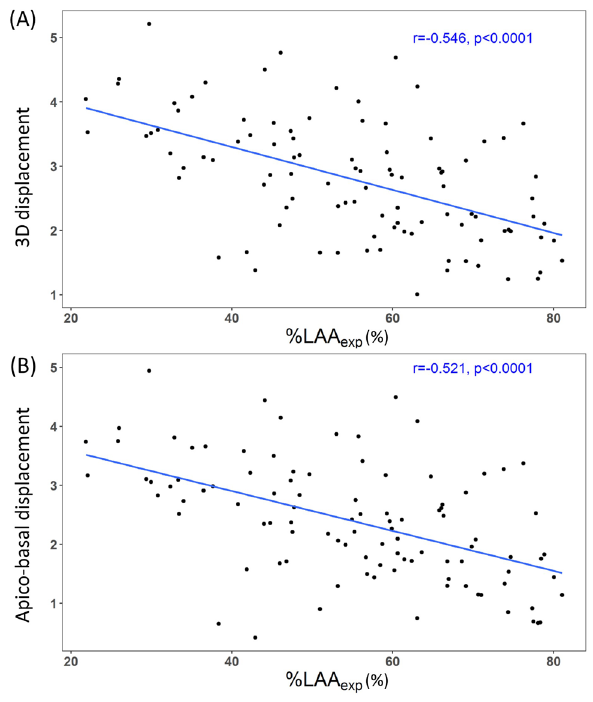
Figure 3. Correlation between %LAA exp and magnitude of displacement vectors in emphysema patients. %LAA exp (%) represents percentage of lung volume on expiration scan with attenuation less than -856 Hounsfield units (HU). ( A ) Correlation between %LAA exp (%) and 3D displacement of the diaphragm. %LAA exp (%) is negatively correlated with 3D displacement of the diaphragm (r = − 0.546, P < 0.0001). ( B ) Correlation between %LAA exp (%) and apico-basal displacement of the diaphragm. %LAA exp (%) is negatively correlated with apico-basal displacement of the diaphragm (r = − 0.521, P <